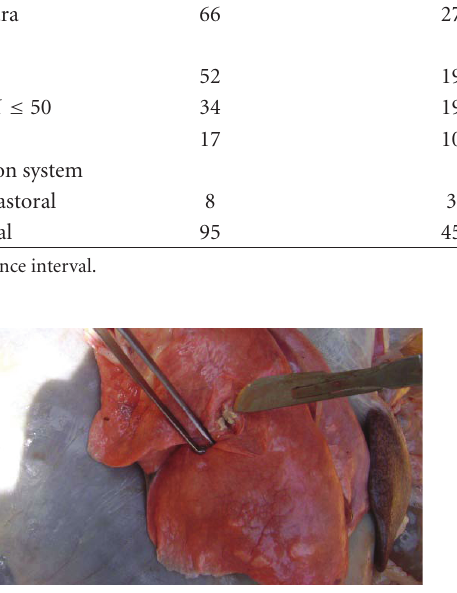
Figure 1: Tuberculous lesion from goat lung caused by Mycobac- terium